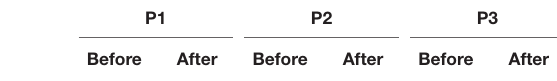
TABLE 4 | Average spasticity measured for both legs of the three patients for the different movements assessed at the beginning (Before) and at the end (After) of every session after the use of the exoskeleton, measured by the MAS. P1 P2 P3 Before After Before After Before